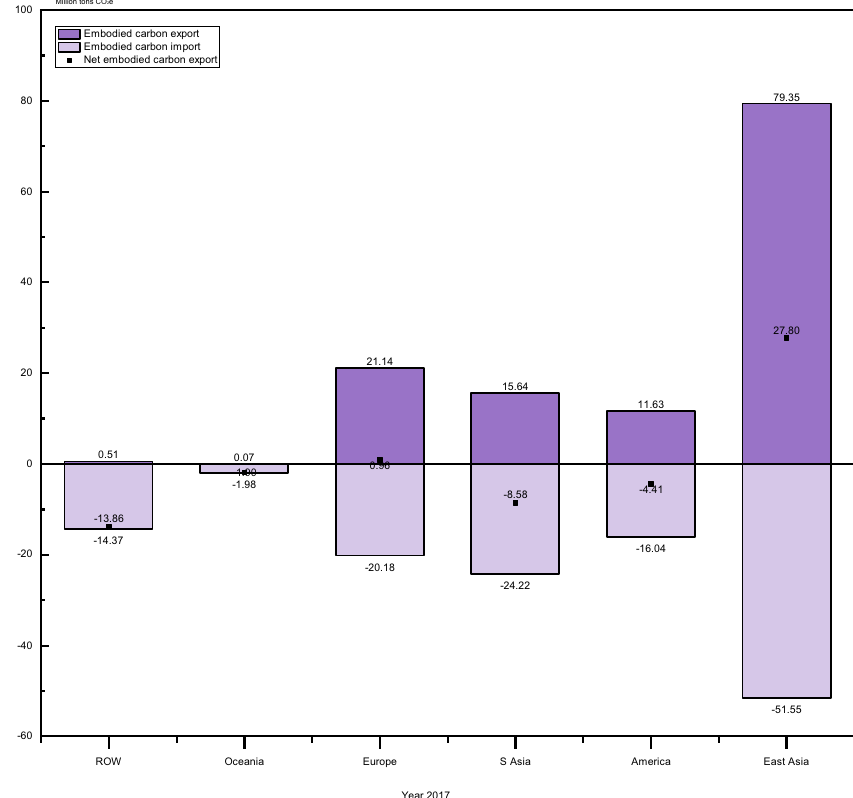
Fig. 3 Balance of carbon emission embodied in the solar photovoltaic (PV) product trade in 2017. S Asia is the abbreviation for Southeast Asia. ROW is the abbreviation for the rest of the world. The column chart shows the balance of total carbon emission embodied in the global PV product trade by region: Dark purple bars above the horizontal axis (y = 0) represent carbon emission embodied in exports, and light purple bars under the horizontal axis represent carbon emission embodied in imports. Black dots represent the balance of embodied carbon emission (BEET C